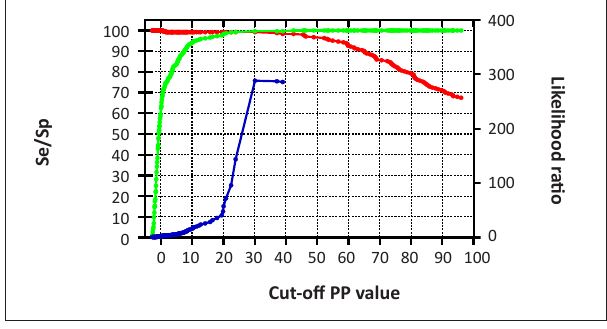
Se/Sp, sensitivity/specificity; PP, percentage positive. FIGURE 6: Receiver operating characteristic analyses of the double-antigen